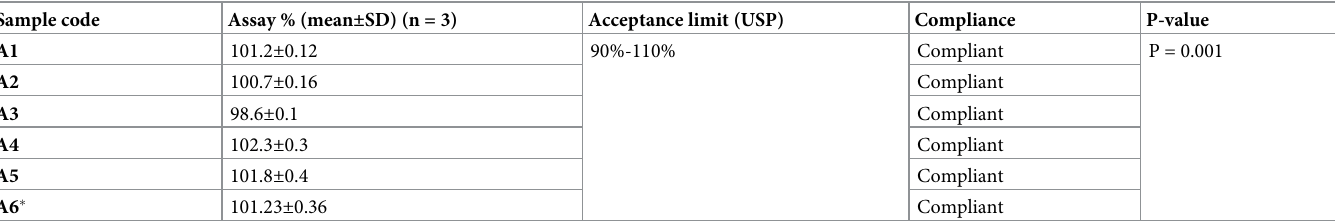
Table 8. Assay test result of Azithromycin tablets. Sample code